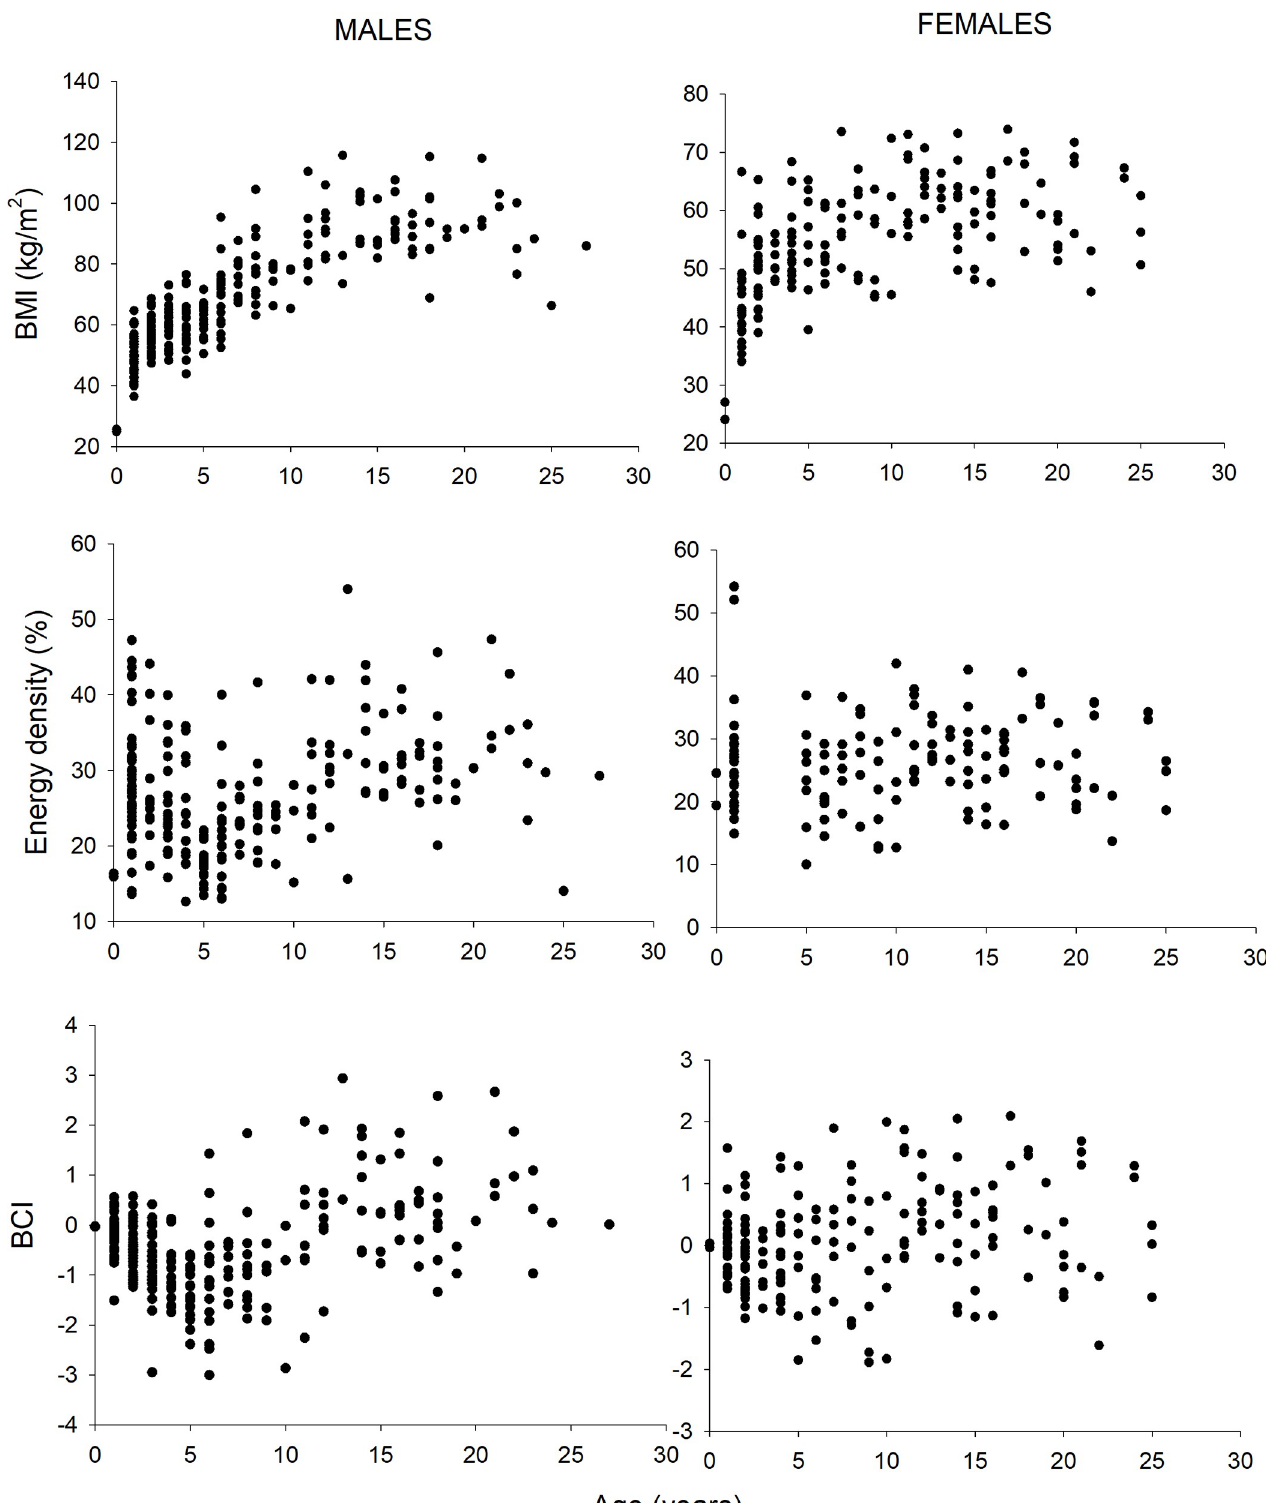
Fig 4. Values of three condition metrics (BCI, BMI, and energy density) relative to age for male and female polar bears captured in the Chukchi Sea.